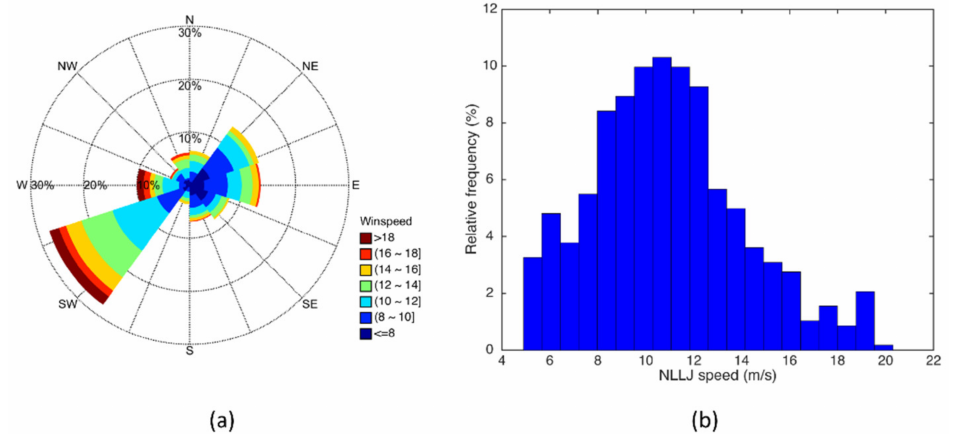
Figure 11. ( a ) Windrose of NLLJ core; NLLJ speed is shown in m/s and the percentage corresponds to the occurrence of NLLJ speed and direction relative to the total amount of NLLJ observed; ( b ) relative frequency distribution of NLLJ